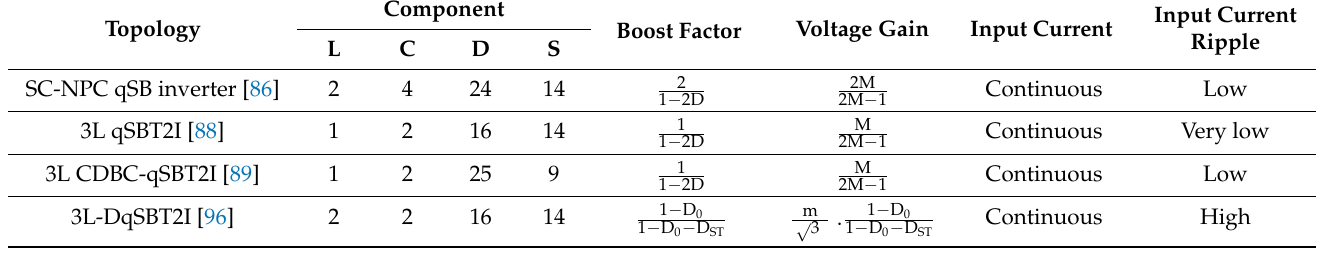
Table 2. Comparison of quasi-switched boost inverter configurations.